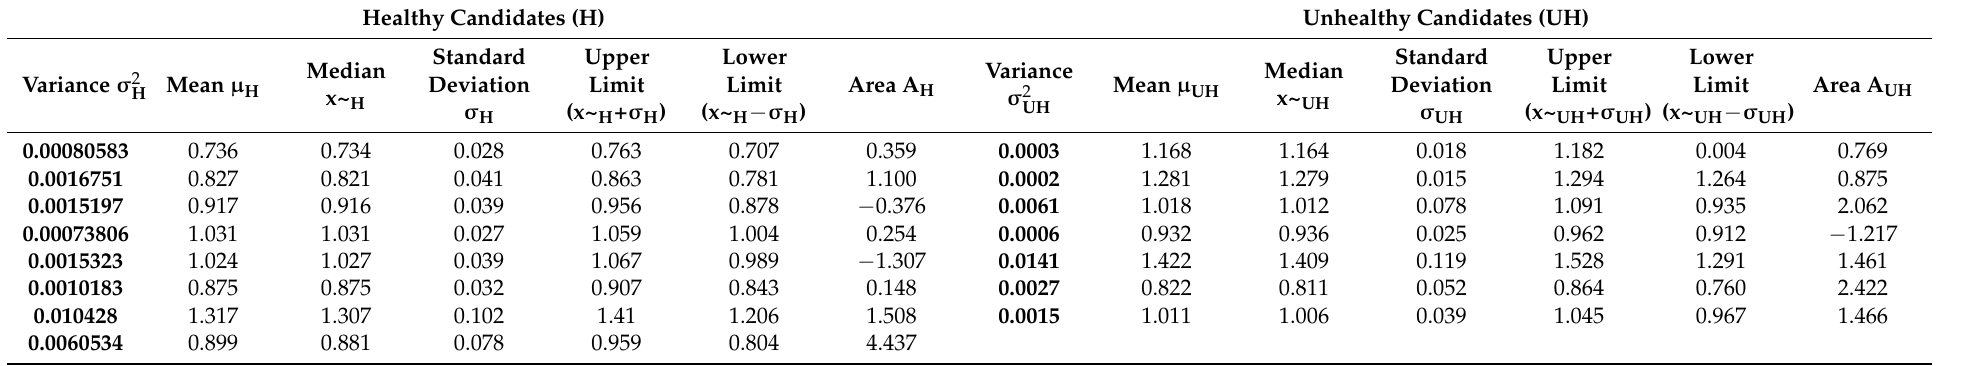
Table 3. Statistical analysis outcome for the combination of parameters QRS interval, RR interval, and JT interval.